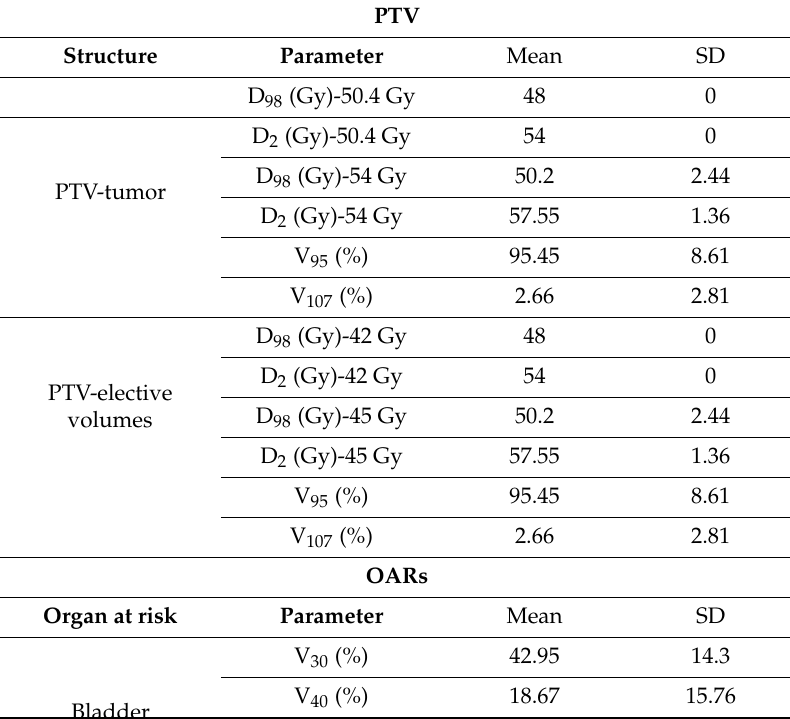
Table 5. Dosimetric parameters for both target volumes and organs at